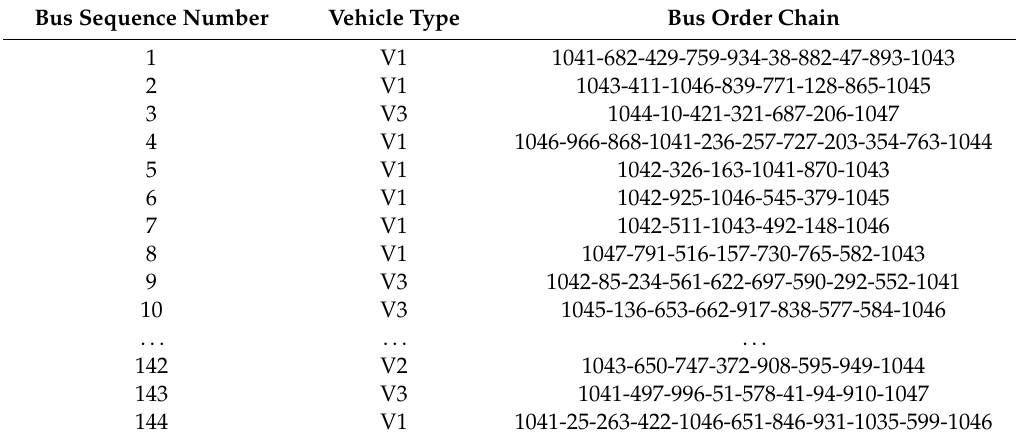
Table 6. Bus order